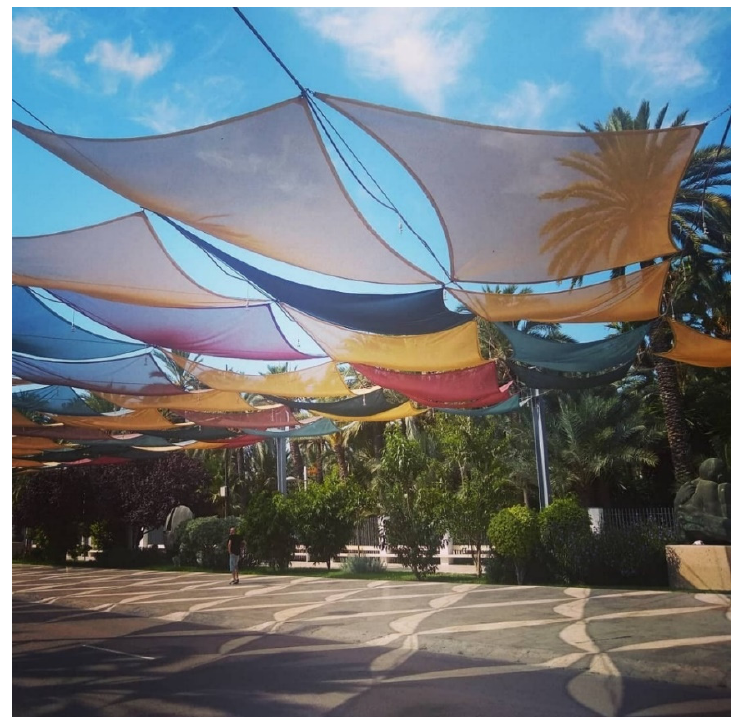
Figure 6. Example of shading sails (Elche, Spain). Photo © Jan